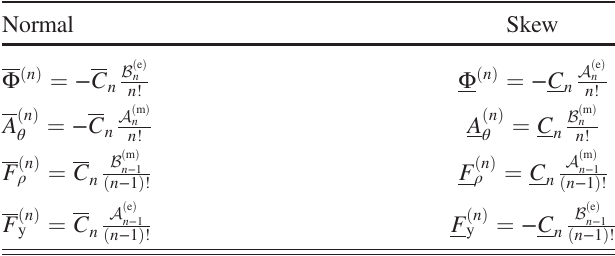
TABLE IV. Formulas for the scalar potential, azimuthal com- ponent of the vector potential and field components for “ pure ” normal and skew 2 n -poles in cylindrical coordinates. Normal